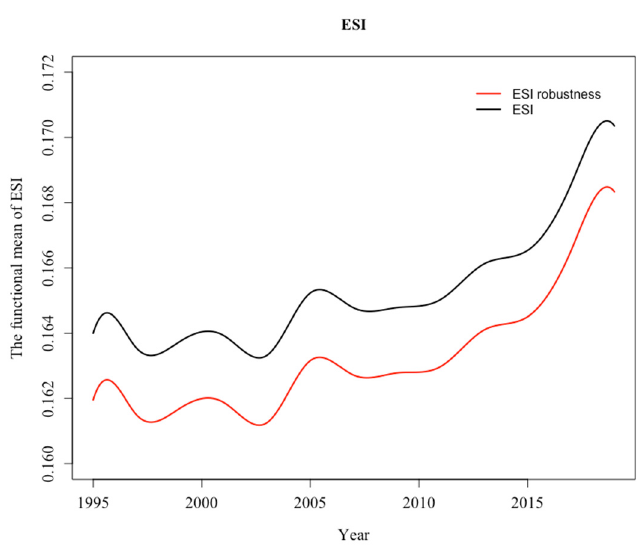
Figure 5. ESI curves for Global corresponding to two methods.